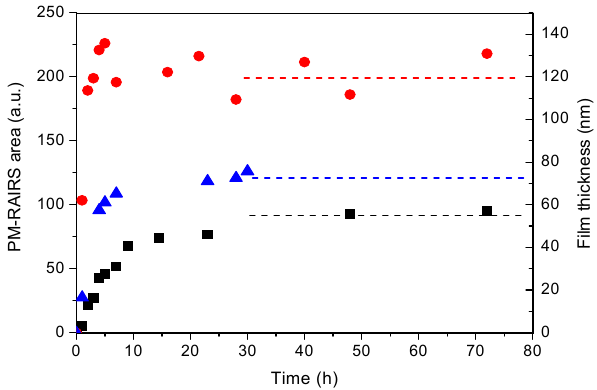
Figure 2. PDA film growth. PM-RAIRS peak area (left axis) and film thickness (right axis) vs. immersion time in DA solution. Data are from Figures S1–S3. Square: PDA–O 2 . Circle: PDA–IO 4 − . Triangle: PDA–PEI.